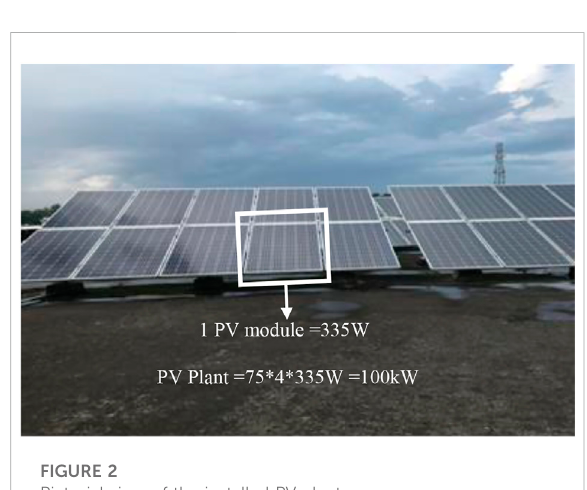
FIGURE 2 Pictorial view of the installed PV